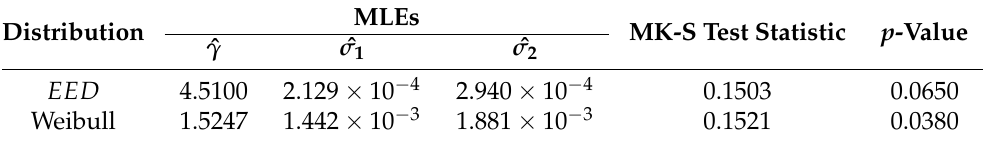
Table 2. Results of MK-S test of EED and Weibull distribution for jute fibre data.